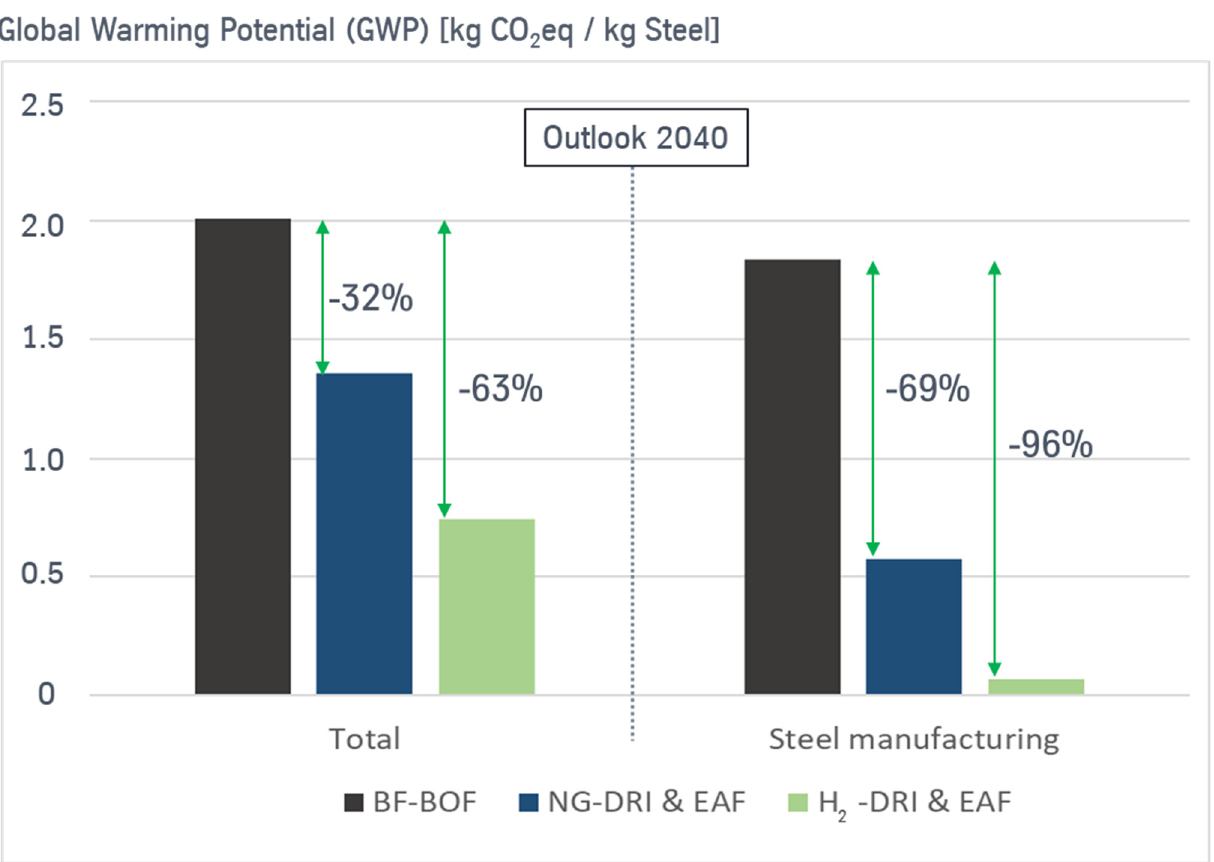
Figure 10. Carbon footprint of steel produced via conventional BF-BOF route, natural gas-based direct reduction–electric arc furnace (NG-DR-EAF) route, and H 2 -DR-EAF route. Hydrogen is gained using electrolysis driven by the European grid mix for the year 2040, referring to the sustainable development scenario of the IEA [34] (see Figure 4b).